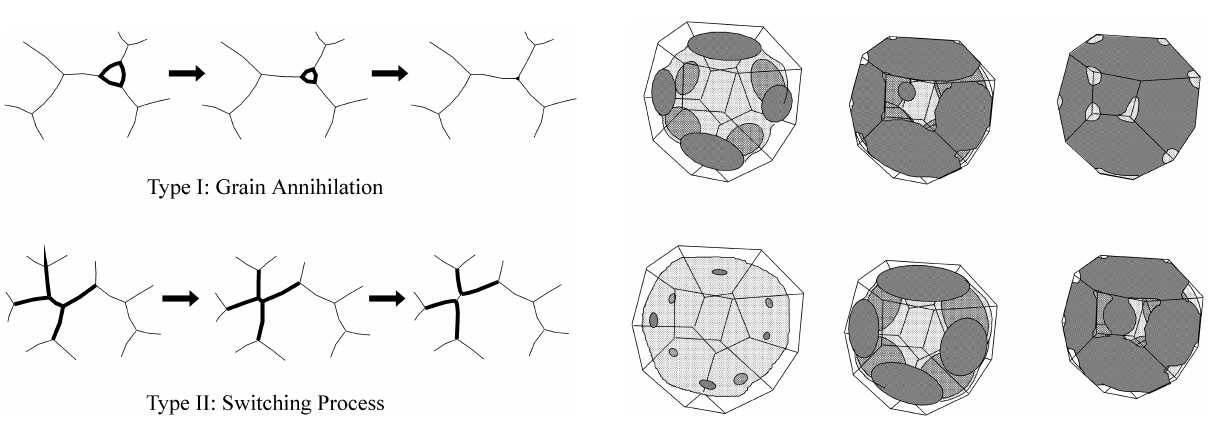
Figure 14. Topological processes that occur in two dimensional grain growth: (a) the disappearance of small grains, and (b) the switching process.